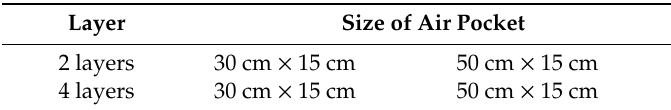
Table 1. Layers and size information of air pocket.